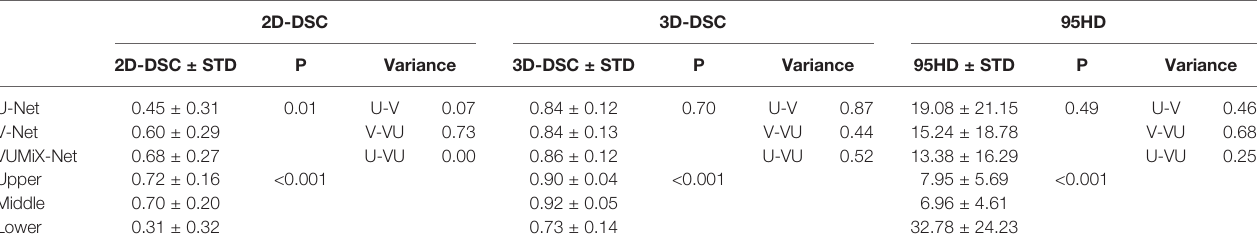
TABLE 2 | Two-dimensional Dice similarity coef fi cient ( 2D-DSC), three-dimensional Dice similarity coef fi cient ( 3D-DSC), and 95th-percentile Hausdorff distance (95HD) values of the gross tumor volume (GTV) contours in different from network architectures and esophageal locations.